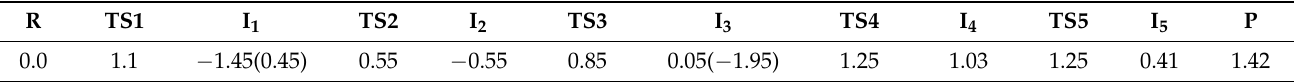
Figure 1. ( Top )—schematic of catalytic dehydrogenation and hydrogen separation by a dual-use membrane. ( Bottom )—energy profile along the pathway of hydrogen abstraction and separation. Table 1. Energies (in eV) of critical points in the energy profile for the hydrogen extraction and separation process. See text for explanation of parenthetical values.